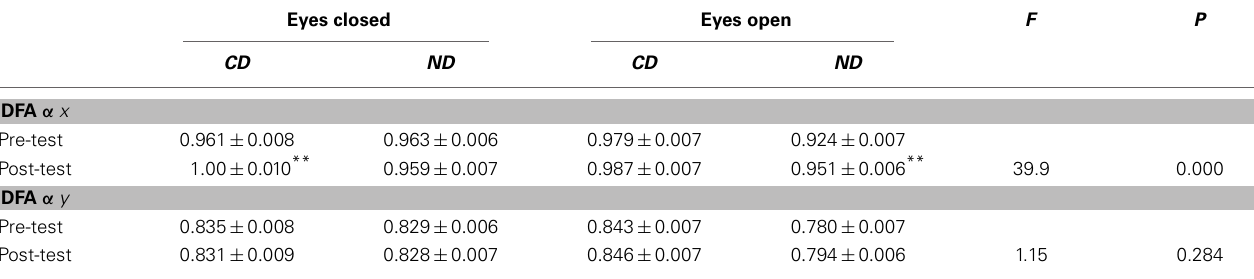
Table 5 | Mean ± SE of detrended fluctuation analysis for the groups of participants (CD, contemporary dance; ND, no dance). Eyes closed Eyes